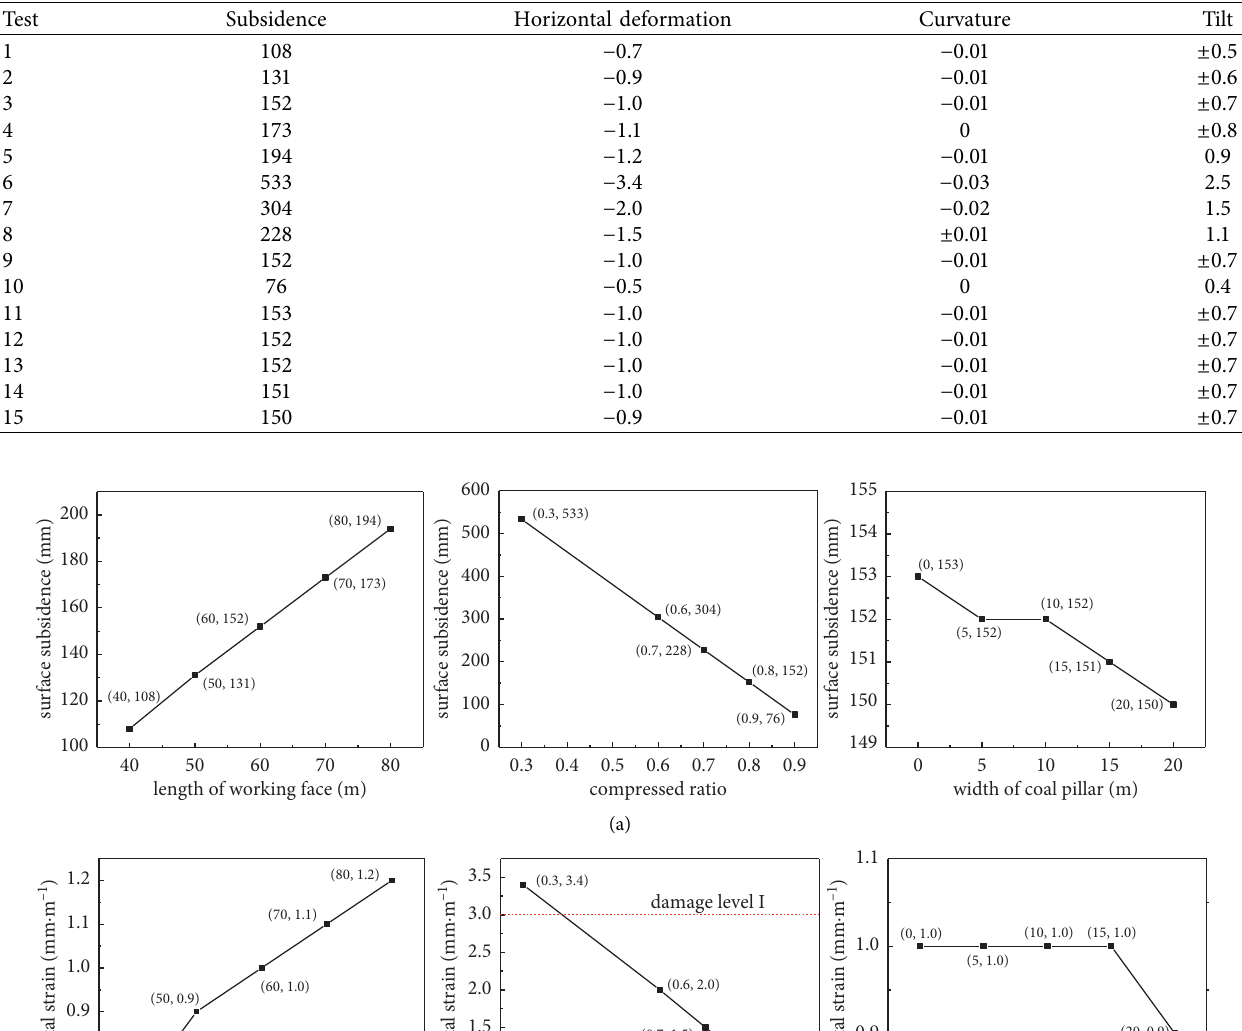
Table 5: Predicted results.